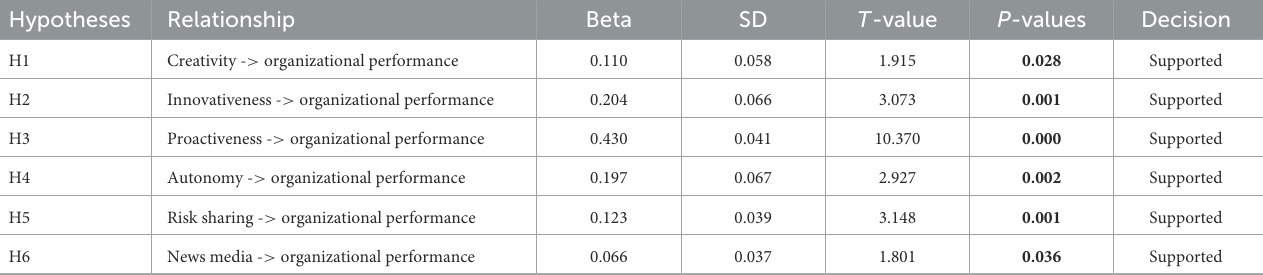
TABLE 7 Direct effects.